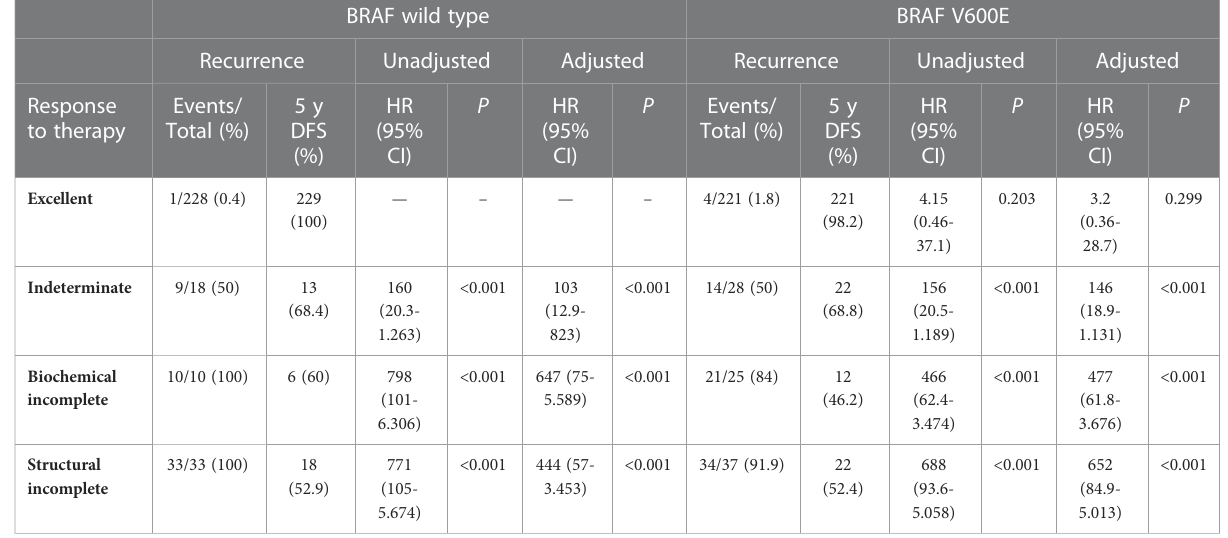
TABLE 7 Hazard Ratios of categories of dynamic risk strati fi cation for 5 years-recurrence by BRAF V600E